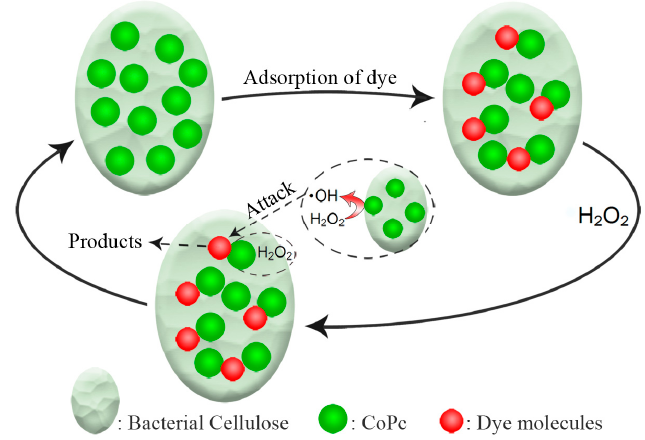
Figure 11. Conceptual representation of catalytic oxidation of reactive red X-3B with CoPc@BC/H 2 O 2 reaction system.